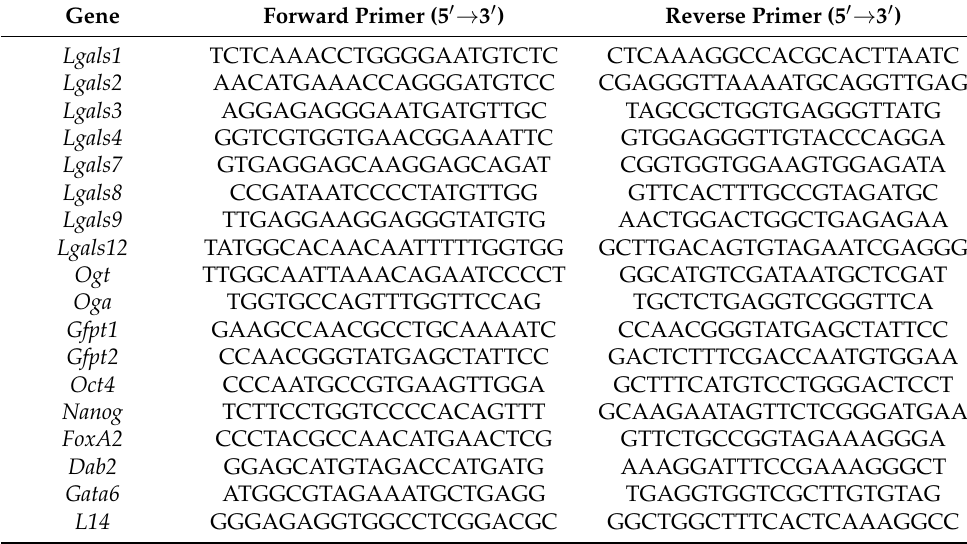
Table 1. Primers used for